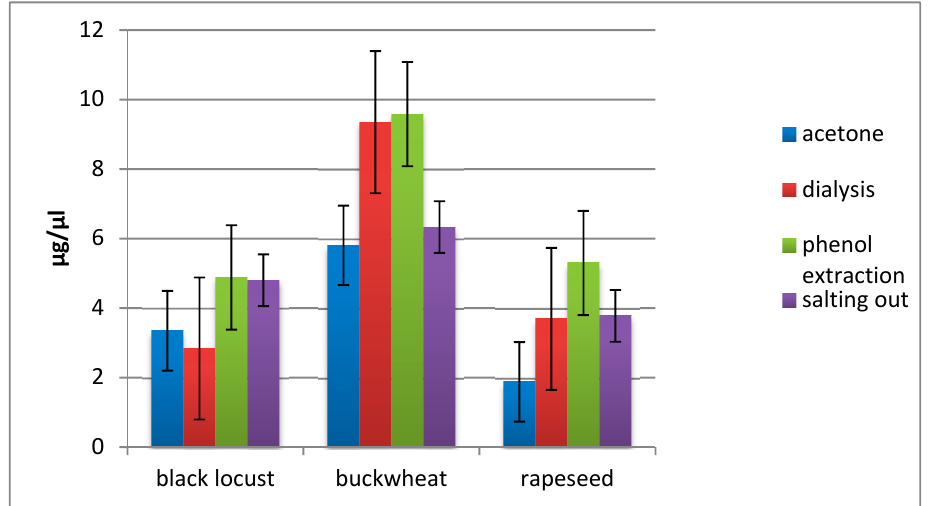
Figure 1. Protein concentration in extracted samples of three Polish honey types after applying four methods of isolation. Measurement performed with the use of 2D Quant Kit in two technical repeats for each of three biological repeats.